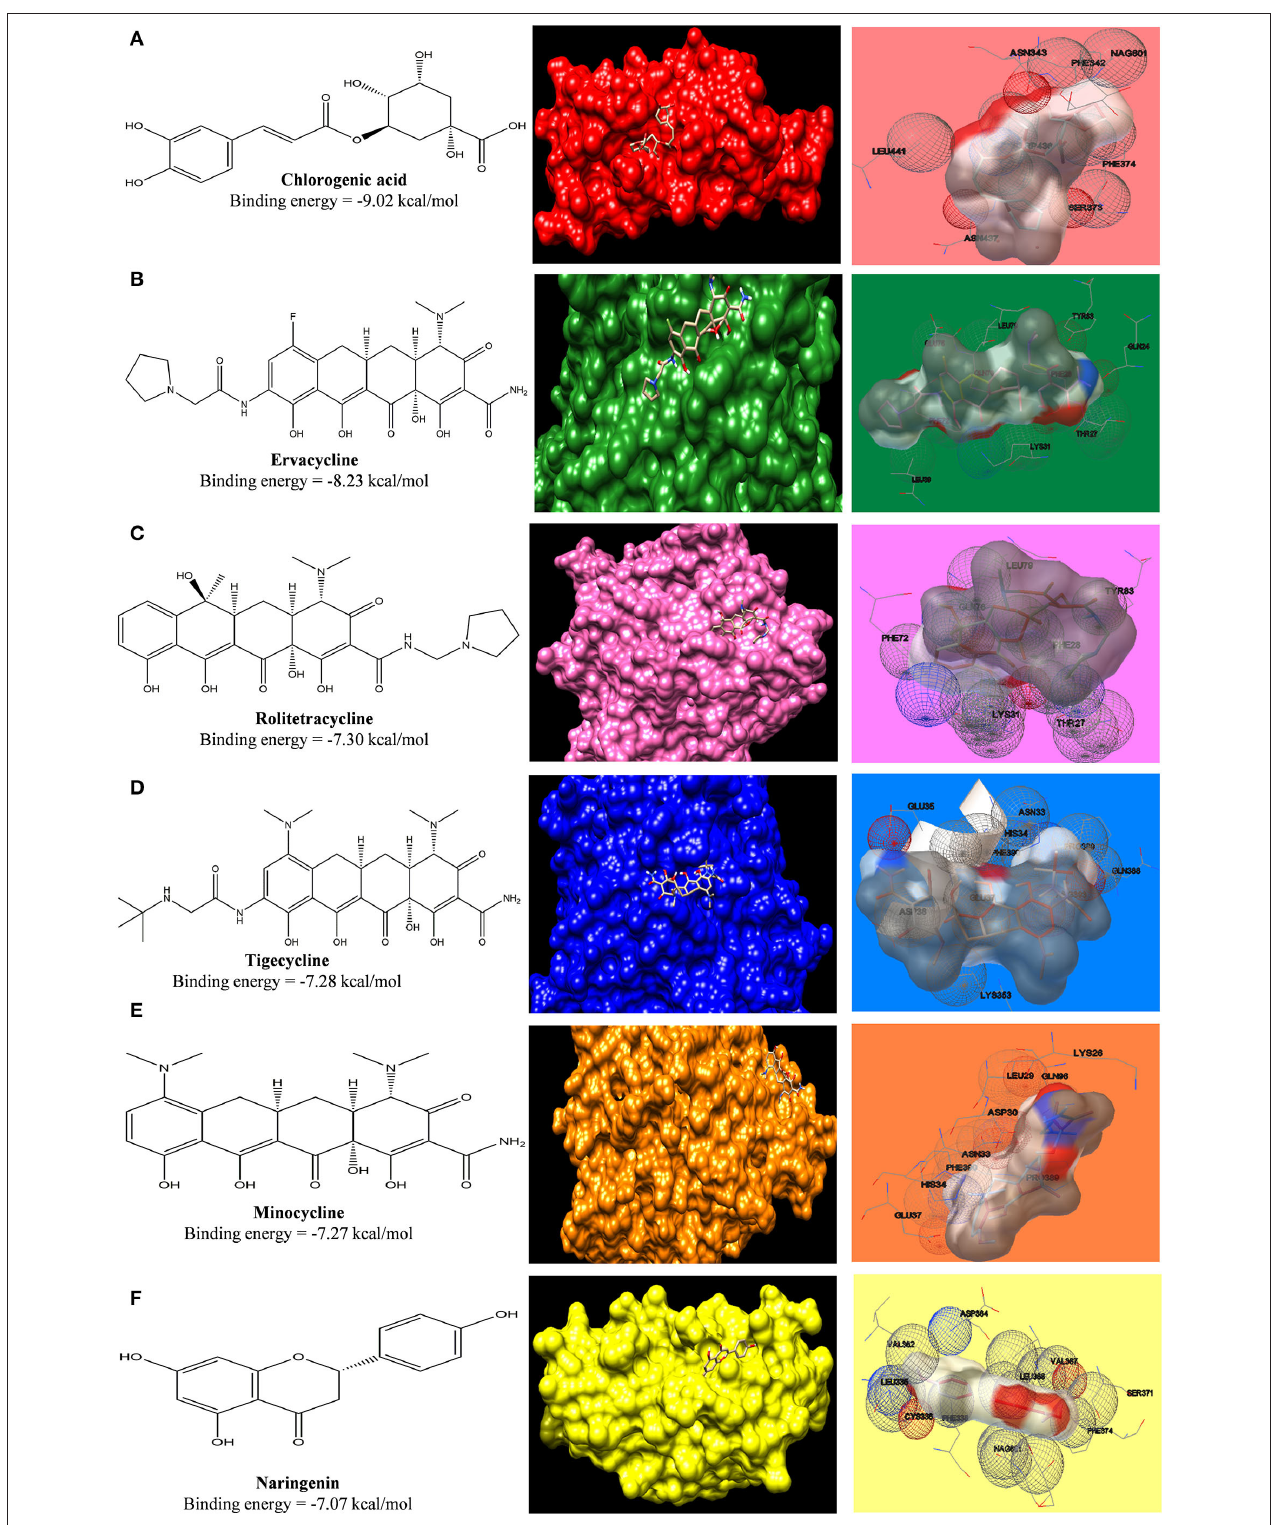
FIGURE 9 | Computed structural comparison and binding features (visualization using UCSF Chimera and AutoDock) of Chlorogenic acid (A) , Ervacycline (B) , Rolitetracycline (C) , Tigecycline (D) , Minocycline (E) , and Naringenin (F) with Angiotensin-Converting Enzyme Receptor 2. The lower the binding energy, the greater will be the binding